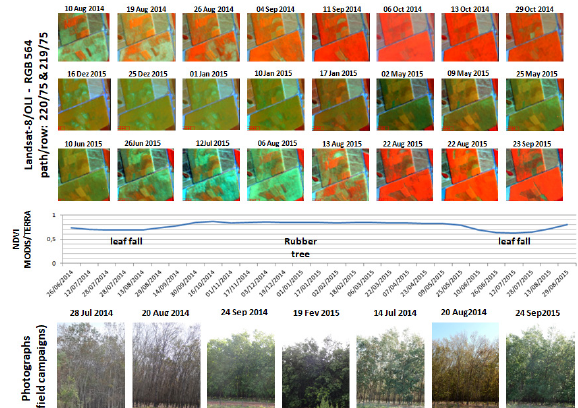
Figure 5. Field and satellite data of an area cultivated with rubber tree. Source: Parts of the figure was adapted from Formaggio and Sanches